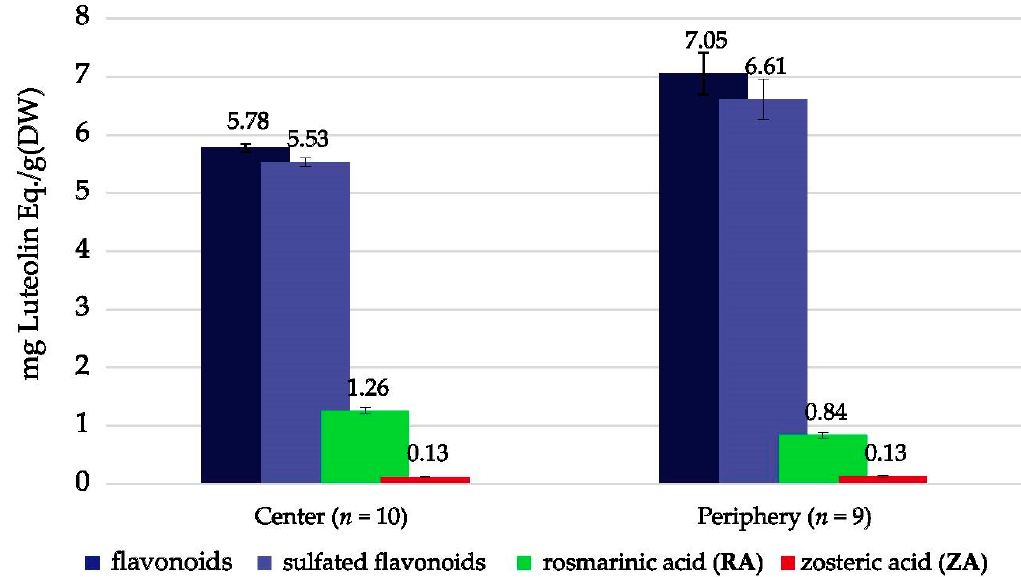
Figure 4. Average of total flavonoids (TF), sulfated flavonoids (TSF), rosmarinic acid (RA) and zosteric acid (ZA) in selected Zostera marina samples ( n = 19) with different positions in seagrass meadows (center samples, n = 10 and periphery samples, n = 9).